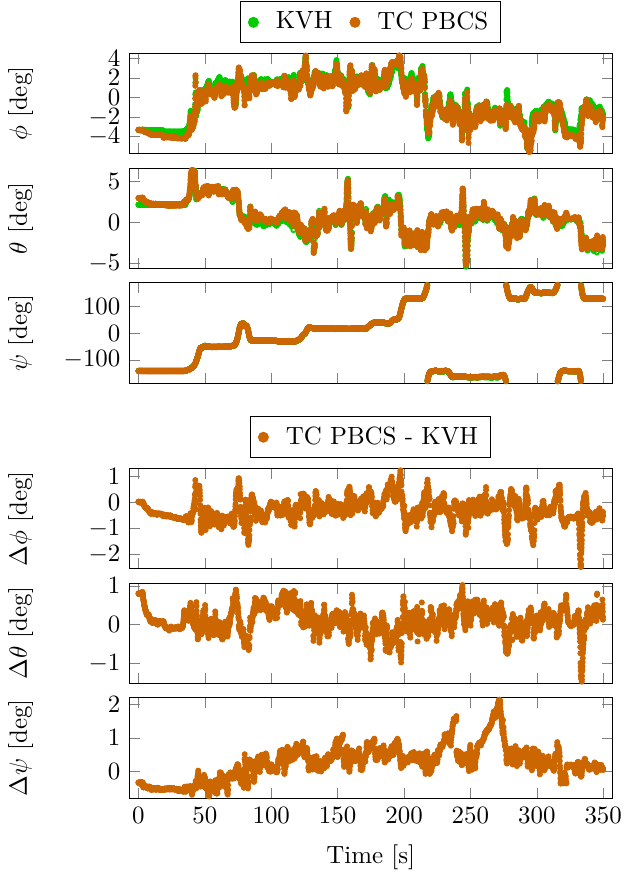
Figure 15. Attitude and attitude angle differences from the KVH unit—Case Study